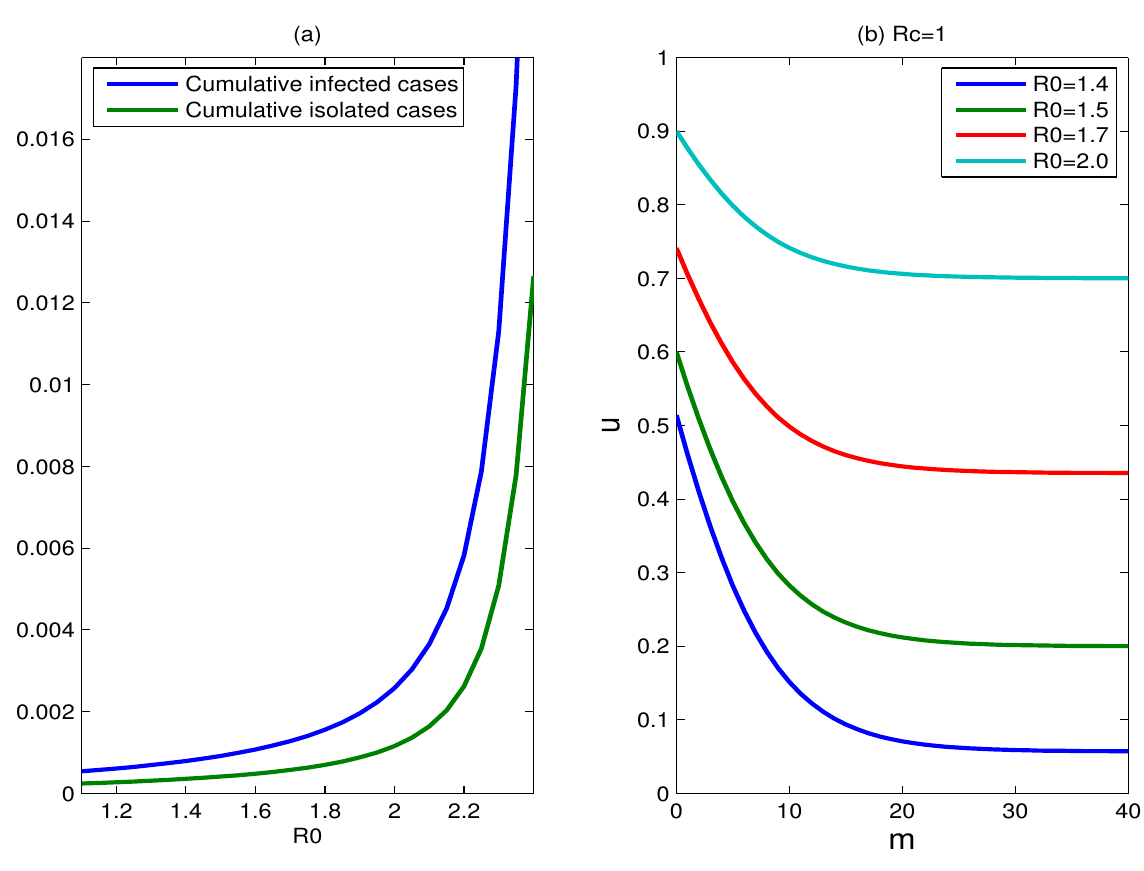
Figure 6. ( a ) Plots of the cumulative percentages of infected individuals and isolated cases during 180 days, as functions of R , where m = 15 , u = 0 . 9 ; ( b ) plots for which R 0 to one for different values of R , where R = 1 . 4 , 1 . 5 , 1 . 7 , 2 . 0 . Every parameter point ( m, u ) 0 0 that corresponds to R < 1 lies above this curve and R > 1 for those points that lie below c c the R = 1 c